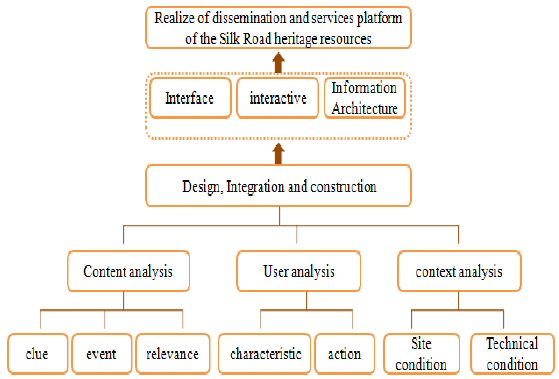
Figure 1: The general research framework of dissemination platform for major cultural resources of the Silk